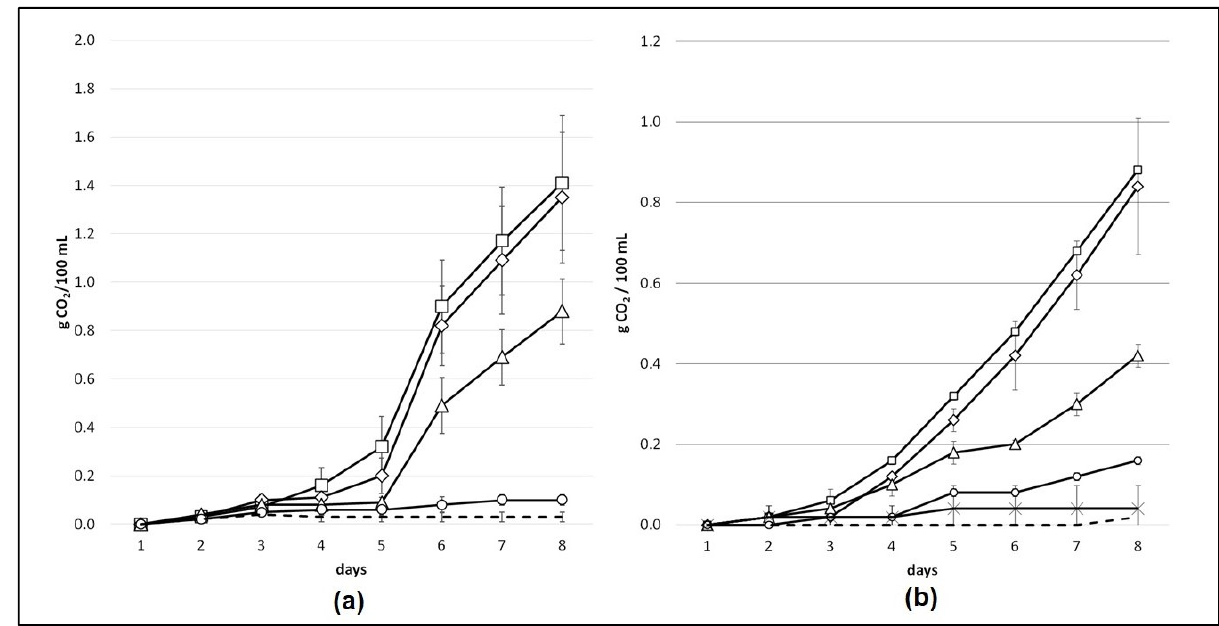
Figure 1. ( a ) Sulfite tolerance. Fermentative activity of the strain K. marxianus Km L2009 in musts without sulfites (— □ —), or with 20 mg/L (— ◊ —), 40 mg/L (— ∆ —), 70 mg/L (— ○ —) sulfites; not inoculated must (- – -). ( b ) Ethanol tolerance. Fermentative activity of the strain K. marxianus Km L2009 in musts without ethanol (— □ —), or with 2% (— ◊ —), 4% (— ∆ —), 6% (— ○ —) and 8% (—×—) ethyl alcohol ( v / v ); not inoculated must (- – -).